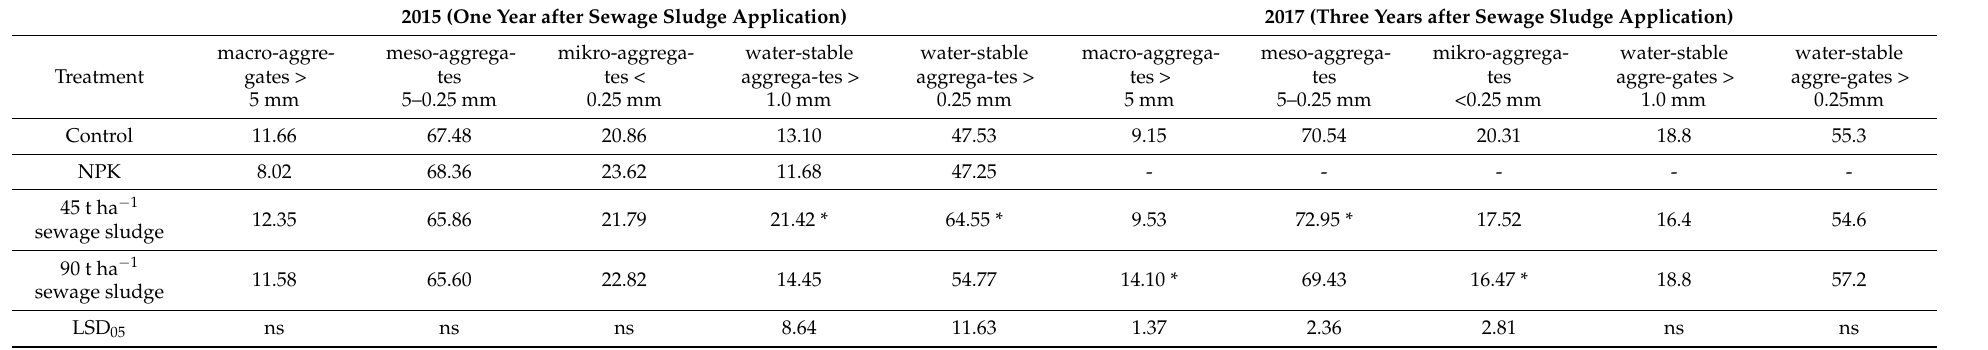
Table 3. Soil aggregate composition and the amount of water-stable aggregates in the growing site of common osier dependent on fertilization type in 2015 and 2017. 2015 (One Year after Sewage Sludge